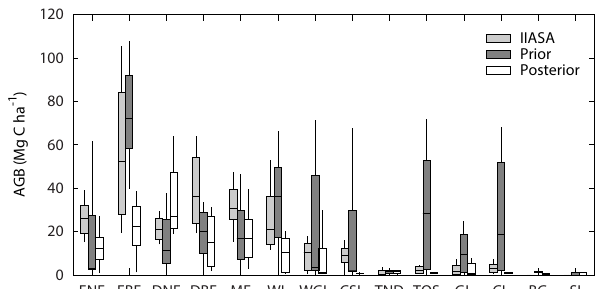
Figure 6. As for Fig. 5, except showing a comparison of NPP val- ues (MgCha − 1 yr − 1 ) for GPPDI and VISIT with prior and poste- rior parameters. The GPPDI does not contain NPP data in the grids corresponding to tundra